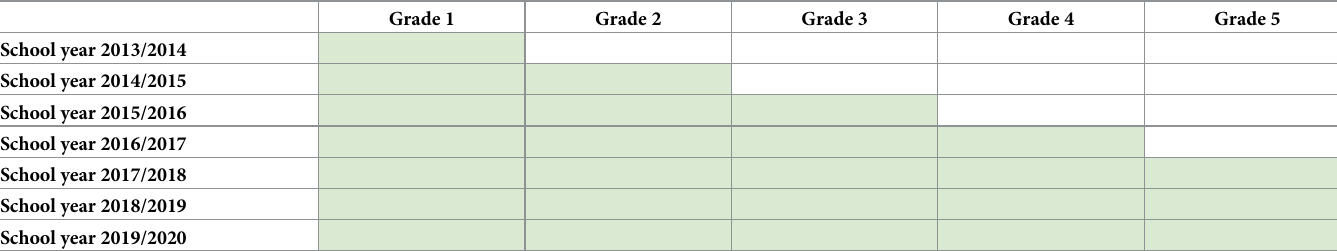
Table 1. Collection of data on standardized tests per school year and grade.